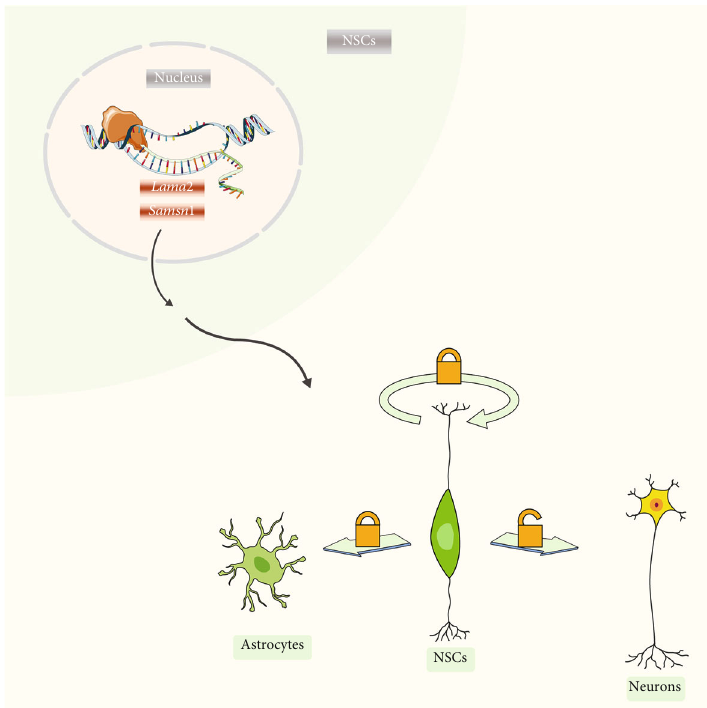
Figure 9: Schematic diagram describing the mechanism of Lama2 and Samsn1-mediated Brn4 e ff ect on di ff erentiation of hippocampal